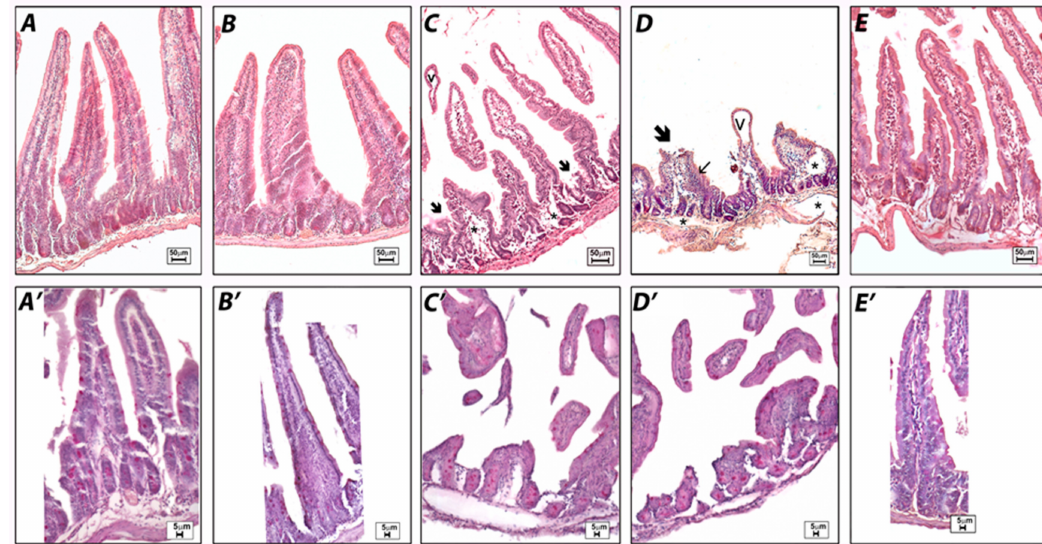
Figure 6. Histological observations of the different treatments on mouse small intestines. Hematoxylin–eosin ( A–E ) and PAS staining ( A (cid:48) – E (cid:48) ). Untreated ( A ) and vehicle ( B ) samples show normal small intestine morphology. Indomethacin ( C ) and ketorolac ( D ) samples demonstrate severe subepithelial vacuolations (v), eroded villi (arrow) with inflammatory infiltrates (small arrow), and edematous areas (*) with also a reduced villi length. The ketogal ( E ) sample demonstrates an improvement in intestine morphology. No significant changes in the production of mucus can be detected in any of the samples observed by PAS (6 A (cid:48) – E (cid:48) ).